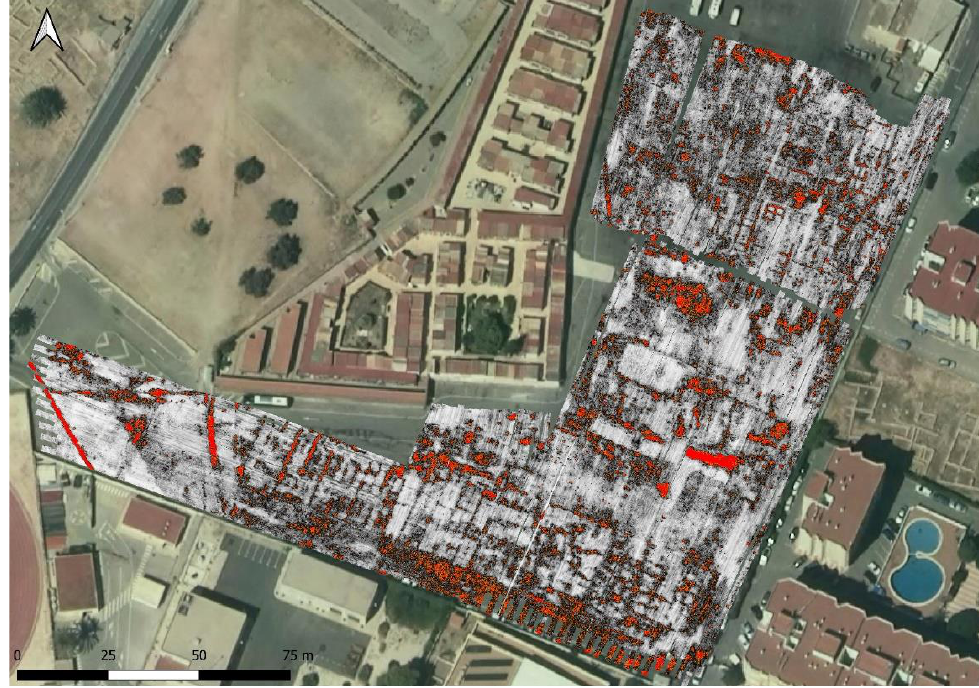
Figure 3. Location of the central study area with GPR (Mercado de Viguetes). Base corresponding to the WMS PNOA (1 – 9 – 2022).